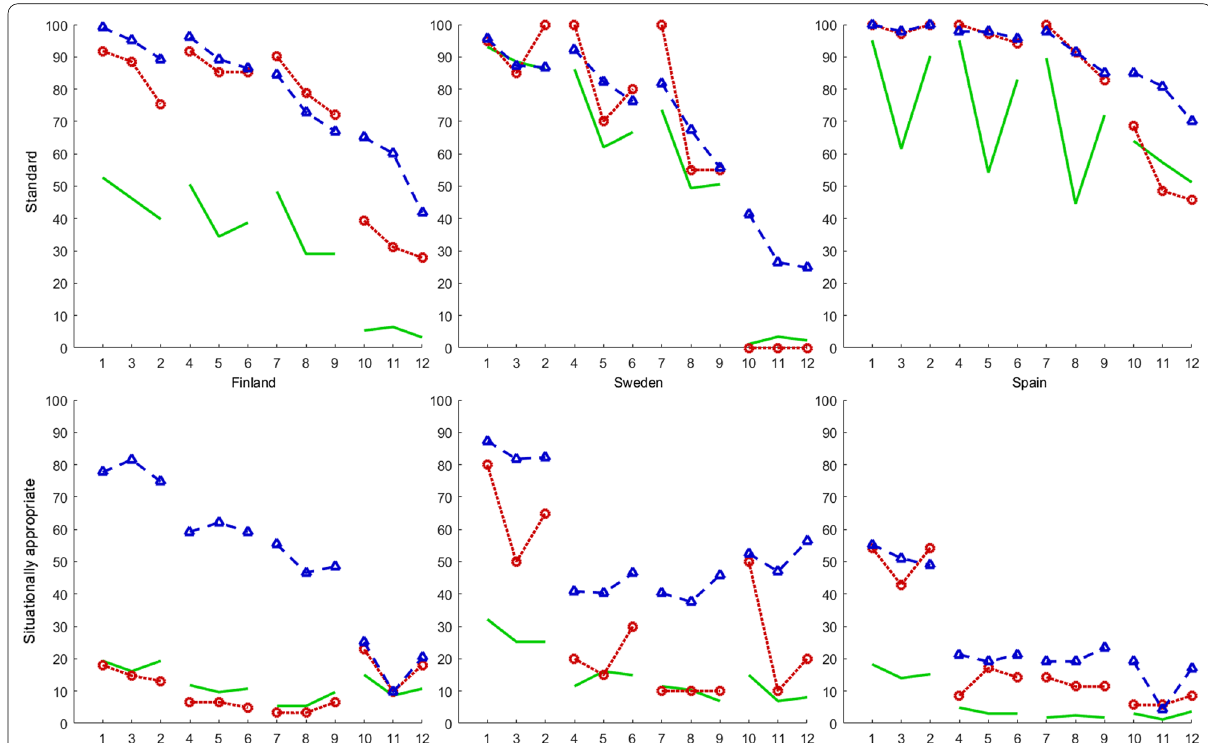
Fig. 1 Average frequency of student use of the standard algorithm (upper three figures) and situationally appropriate strategies (lower three figures) produced per task in percent per level. Note Levels are middle school (solid green), basic math track high school (dotted red circle) and advanced math track high school (dashed blue triangle). The first three tasks are presented in the order 1–3–2, so that each of the three first blocks is in integer–fraction–decimal coefficient